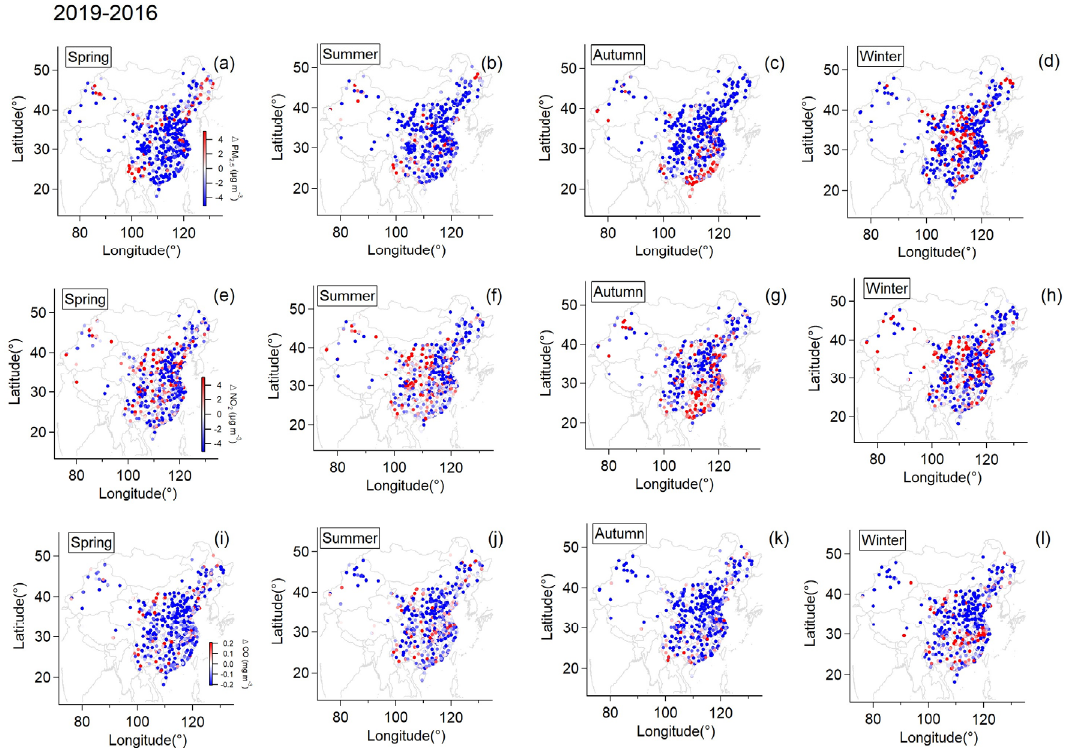
Figure 4. The difference in seasonal averaged daily mean PM 2.5 concentration ( a – d ), seasonal averaged daily mean NO 2 concentration ( e – h ) and seasonal averaged daily mean CO concentration ( i – l ) for individual monitoring stations between the two years.